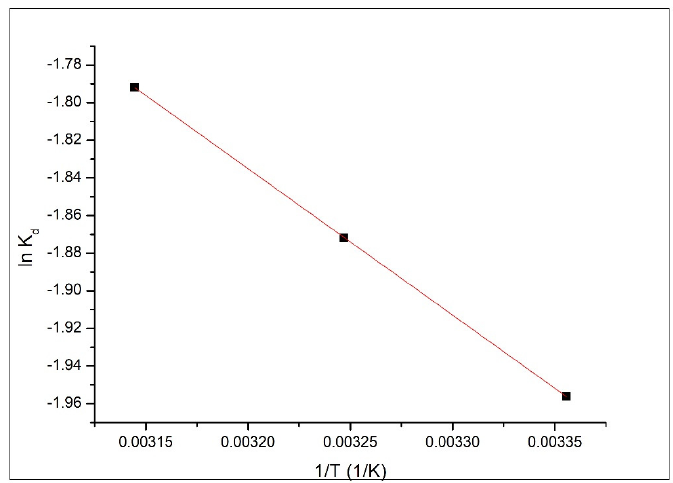
Figure 11. ln k d = f ( 1 / T ). Table 2. Thermodynamic parameters for adsorption of silver onto cotton.